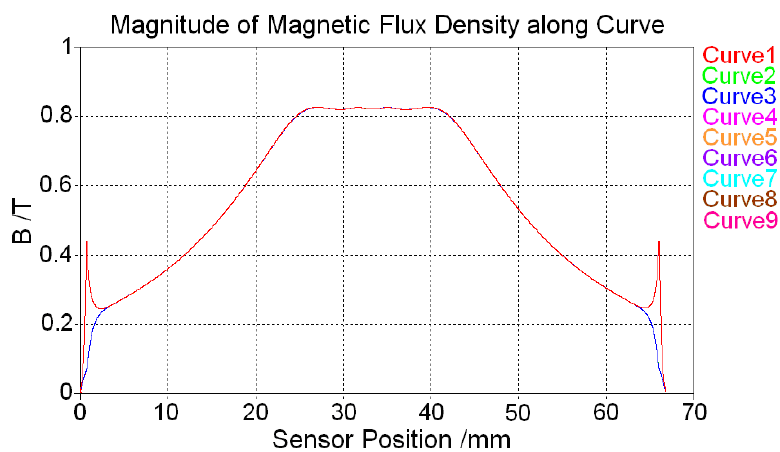
Figure 6. Magnetic field distribution in the soft magnetic